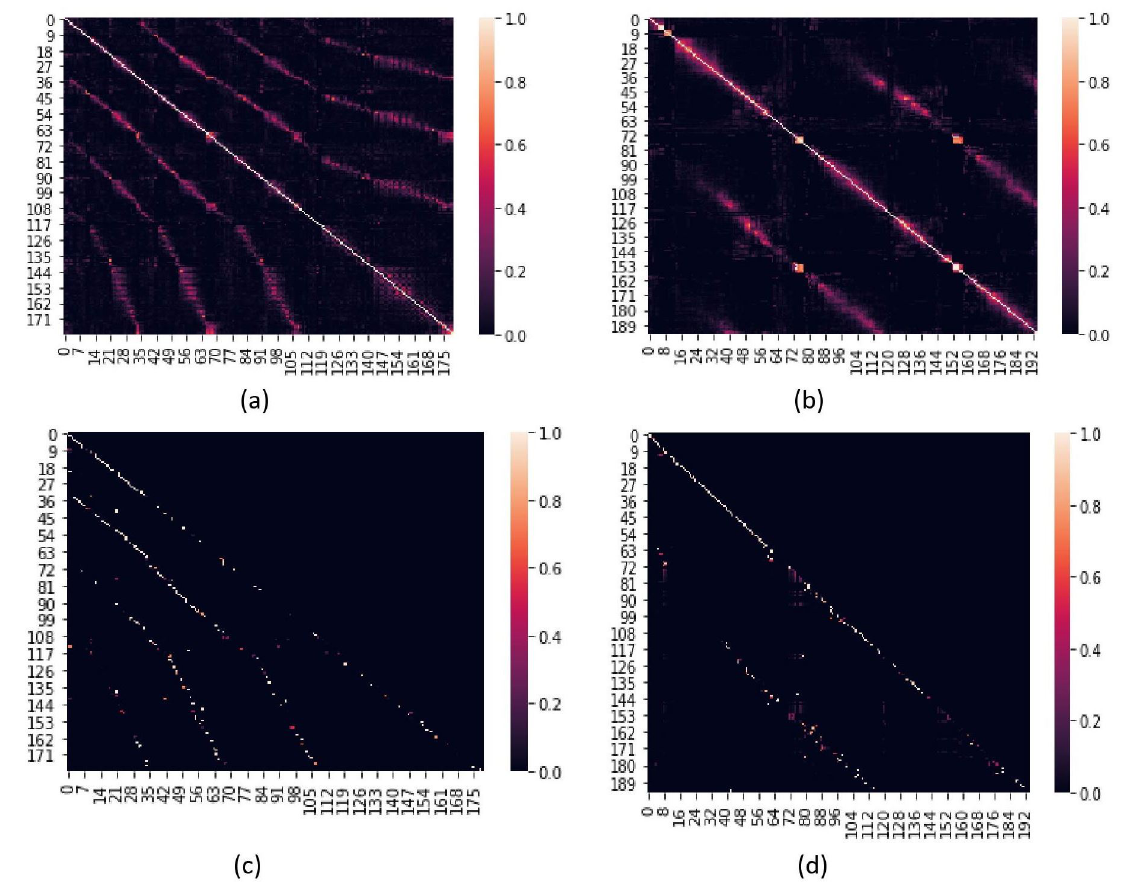
Figure 11. ( a ) Newer College dataset (three loops), ( b ) Portion of New College dataset (one loop) (Ultrametric-BoW), ( c ) Newer College dataset (three loops), ( d ) Portion of New College dataset) (one loop (Ultrametric-FABMAP).